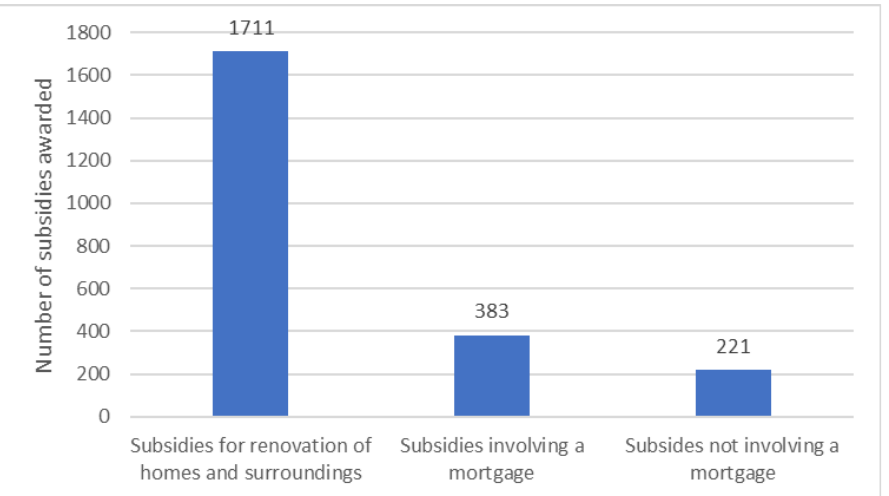
Figure 10. Number of subsidies awarded in Pucón by type, 2009 – 2020. Source: compiled by the authors using Transferencia Activa (freedom of information) data.